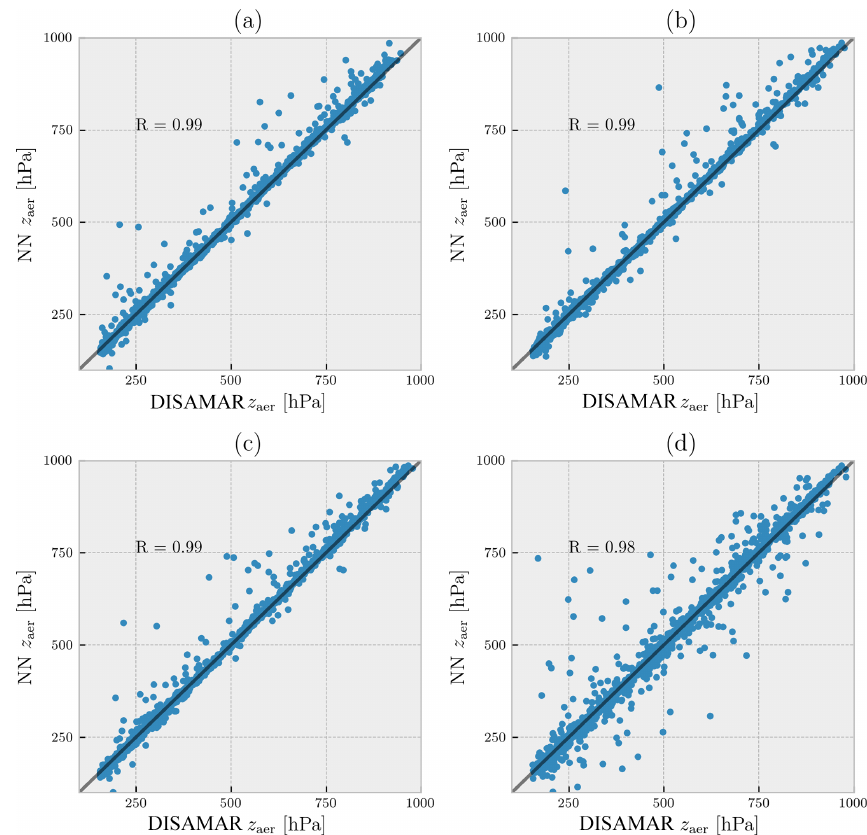
Figure 5. Retrieved layer heights compared between DISAMAR and NN for 2000 synthetic spectra in the presence of model errors. The dots represent converged scenes only, with the x axis representing retrievals from DISAMAR and the y axis representing the same from NN. The model errors represented in this figure are (a) aerosol layer pressure thickness, (b) aerosol single scattering albedo, (c) aerosol scattering phase function asymmetry factor, and (d) surface albedo. These results as well as the introduced model errors are summarised in Table 3. The Pearson correlation coefficient ( R ) between the retrieved z aer from different methods is mentioned in each of the plots. Table 3. A count of converged and non-converged results from synthetic experiments (sim) comparing retrieved (ret) aerosol layer heights between DISAMAR and NN. Experiment DISAMAR NN Model parameter Value in sim Value in ret Converged Non-converged